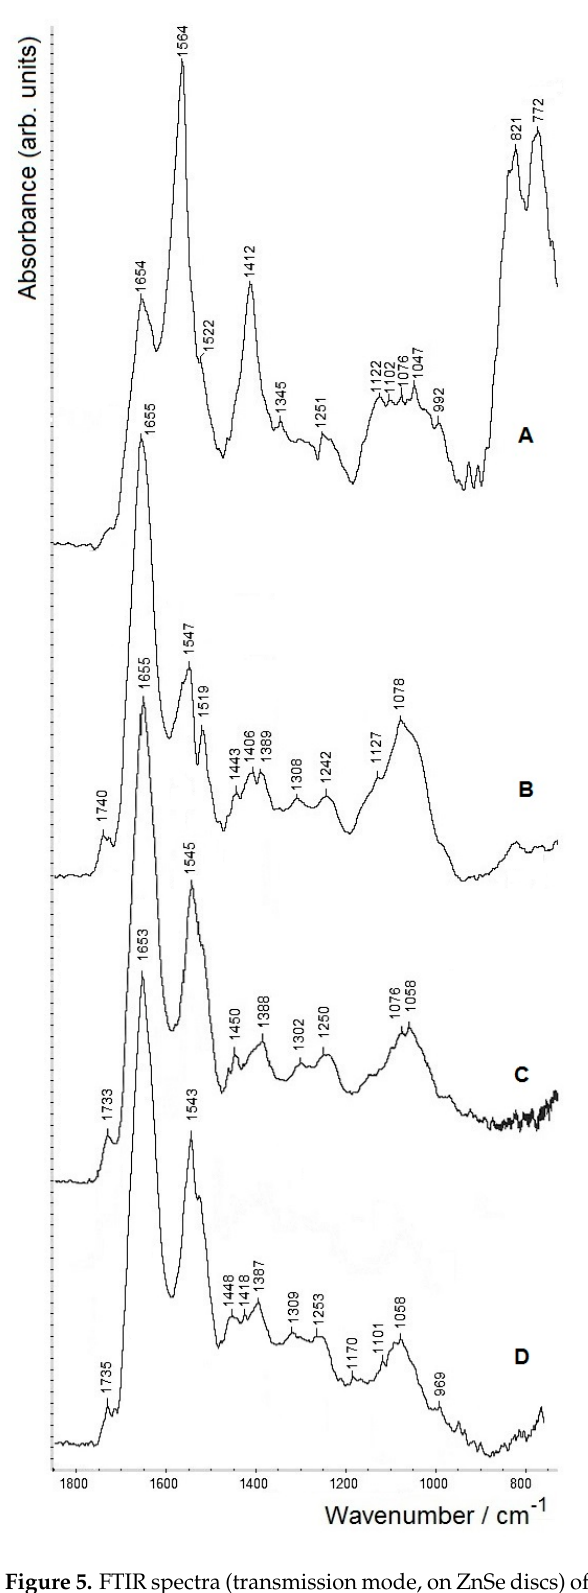
Figure 5. FTIR spectra (transmission mode, on ZnSe discs) of isolated biogenic selenium nanoparticles (SeNPs) obtained using A. brasilense Sp7, measured without washing ( A ) and after 1 ( B ), 2 ( C ) and 3 ( D ) washing steps. Spectra A – C are vertically shifted from the baseline (which corresponds to spectrum D ) for clarity.